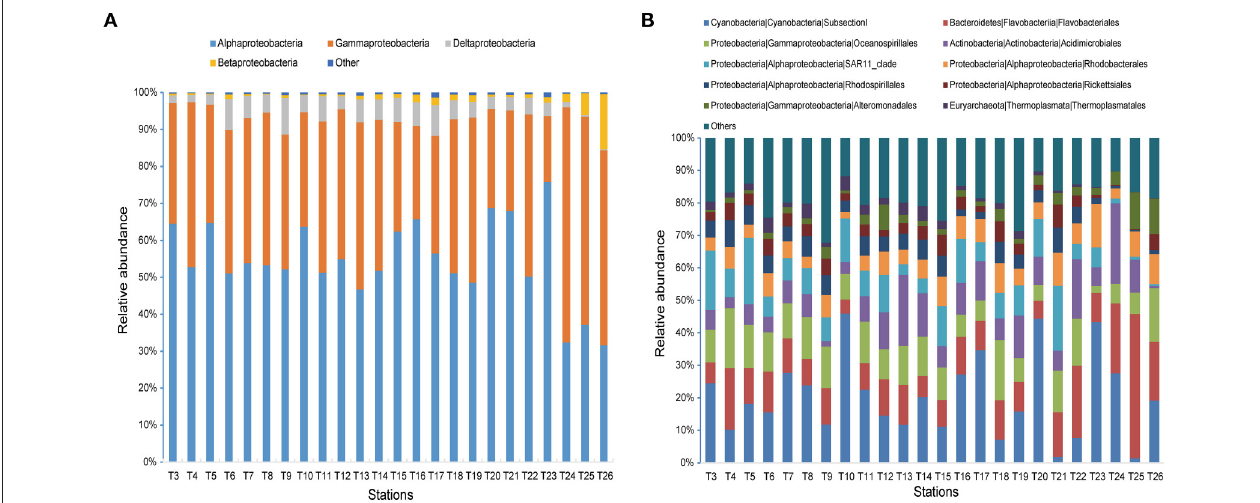
FIGURE 5 | Microbial community compositions across all 24 samples. (A) The relative abundances of different classes in Proteobacteria. (B) The relative abundances of the dominant 10 orders.